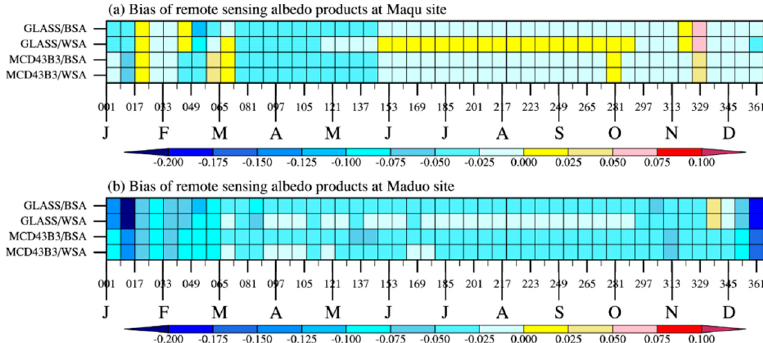
Figure 4. The biases between remote sensing albedo products and ground-based observation at ( a ) Maqu and ( b ) Maduo